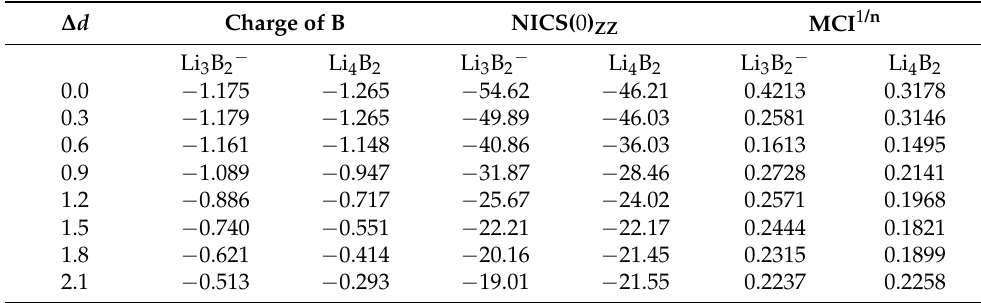
Table 3. Natural atomic charges of B atoms, NICS ( 0 ) which the B–B distances were simultaneously elongated by ∆ d value, while the Li-nuclei positions were kept unchanged.